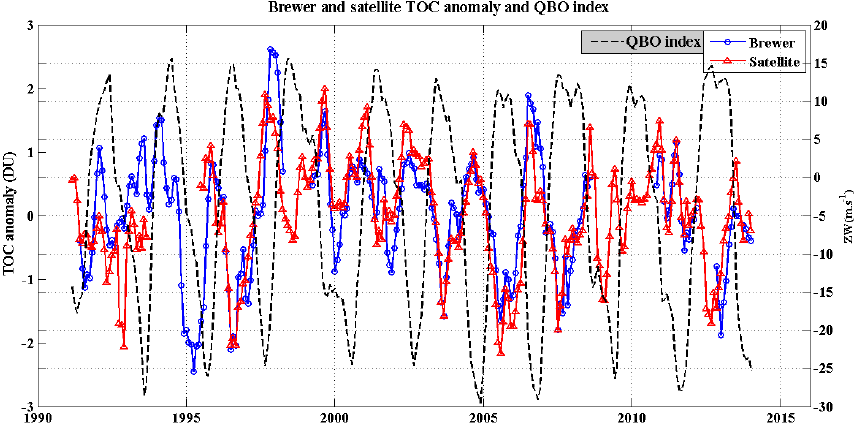
Figure 7. TOC monthly anomaly time series by Brewer spectrophotometer (blue) and satellite instruments (red) over the Southern Space Observatory compared with the QBO index (dashed line) between 1992 and